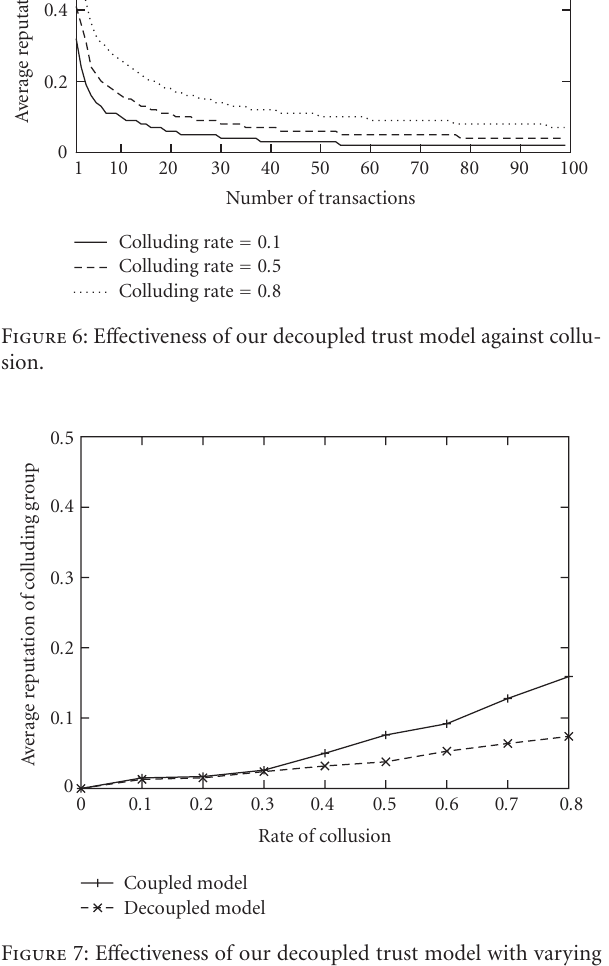
Figure 7: E ff ectiveness of our decoupled trust model with varying rates of collusion.